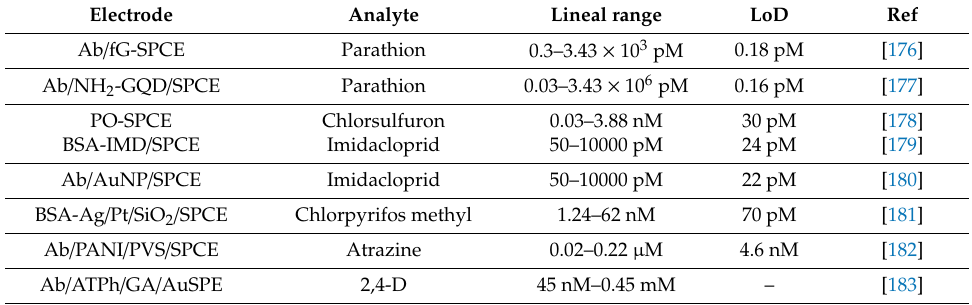
Table 4. Immunosensors reported for pesticides determination on screen-printed